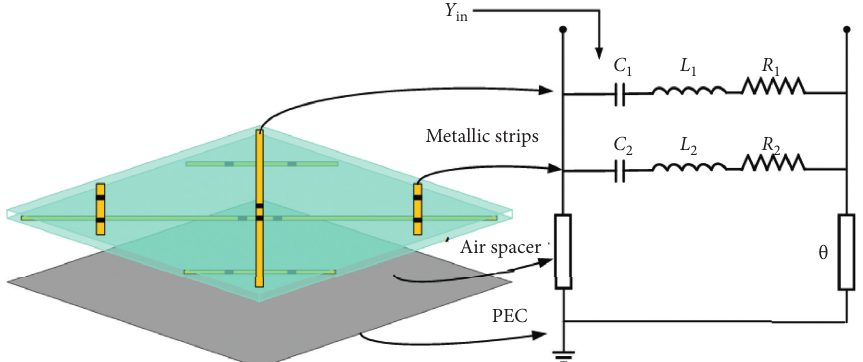
Figure 2: Equivalent circuit model of the proposed absorber for normal incidence with TE polarization.